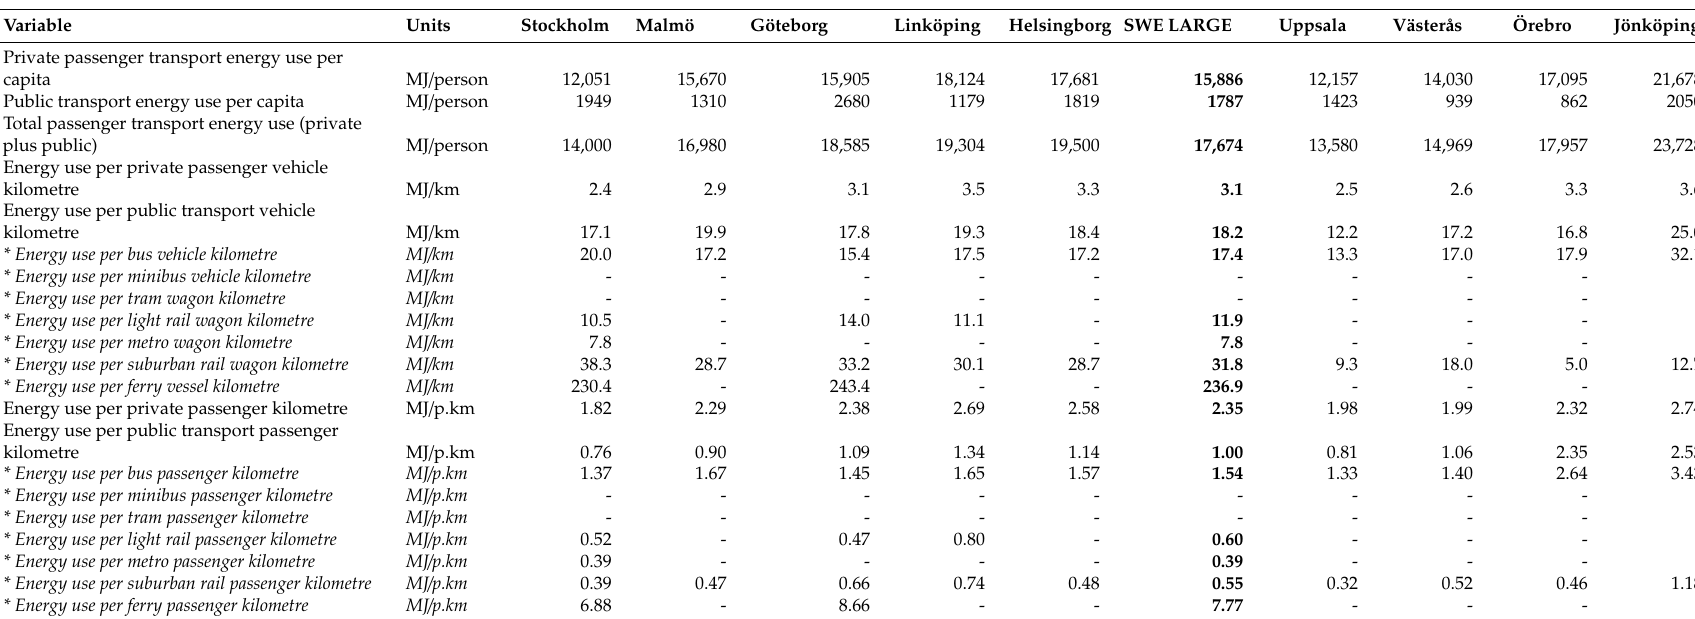
Table 3. Private and public transport energy use per capita and modal energy use in ten Swedish cities (2015), plus Freiburg im Breisgau (2015), compared to American, Australian, Canadian, European and Asian cities